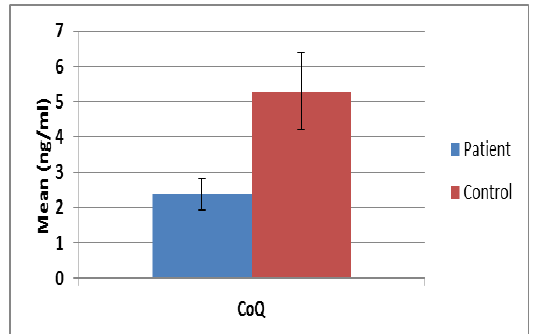
Figure 4. The mean serum Co Q level (ng/ml) in FMS and control (P value <0.01)